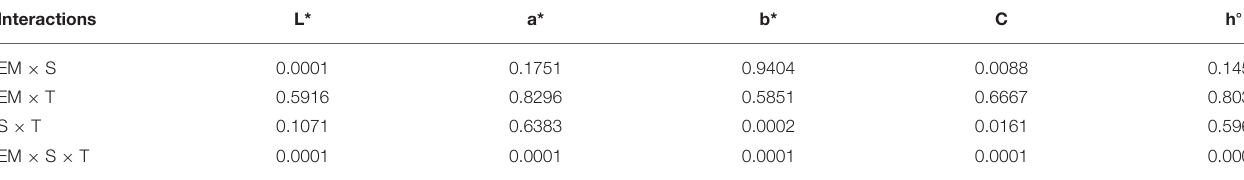
TABLE 5 | Significance of interactions of varied factors in the treatment of nettle alcoholic extracts for chromaticity parameters. Interactions L* a* b* C h ◦ EM × S 0.0001